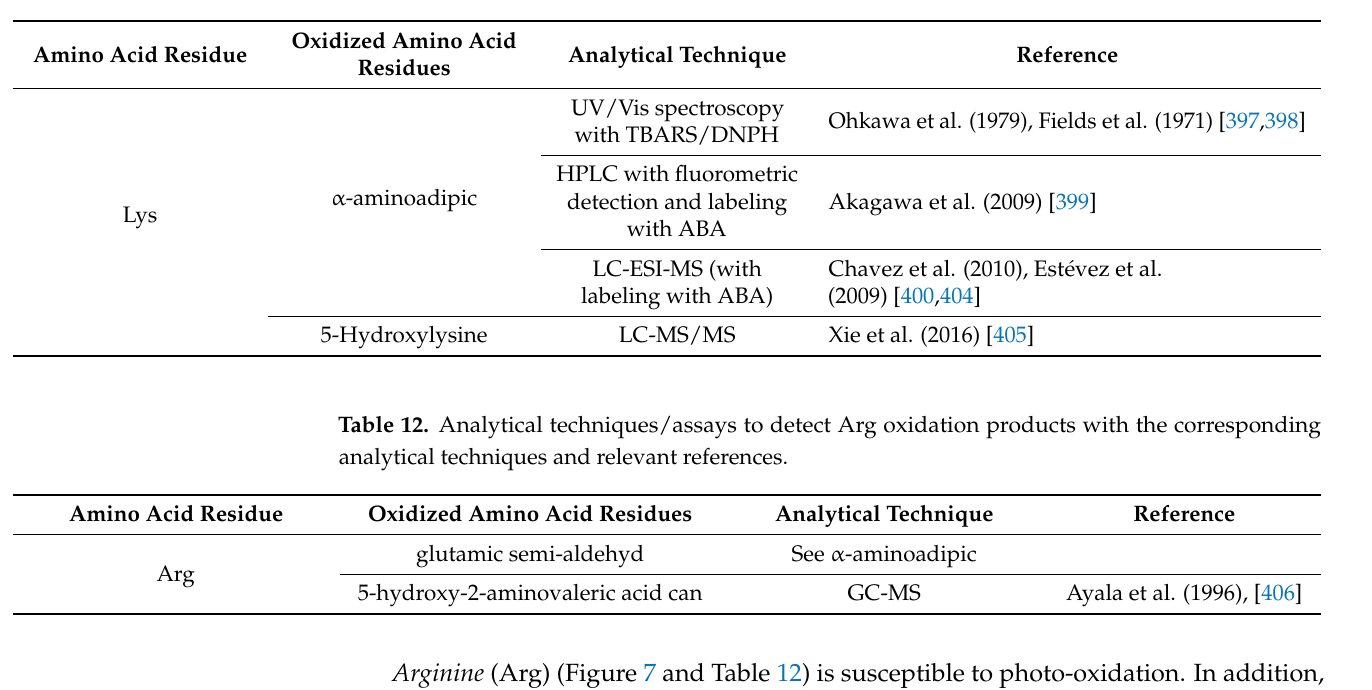
Table 11. Analytical techniques/assays to detect Lys oxidation products with the corresponding analytical techniques and relevant references.